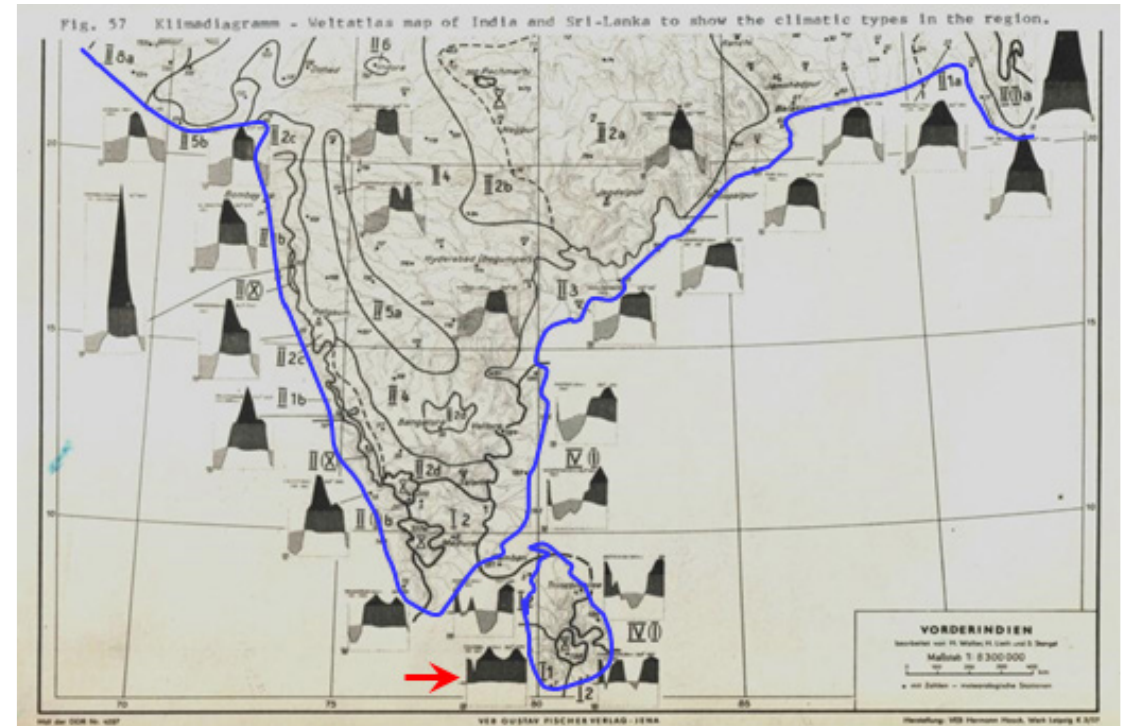
Figure 1B: Walter’s climadiagram showing aseasonal perhumid climate ( i.e . all monthly average >100 mm indicated by a red arrow) surviving only in southwest Sri Lanka in the entire Indian